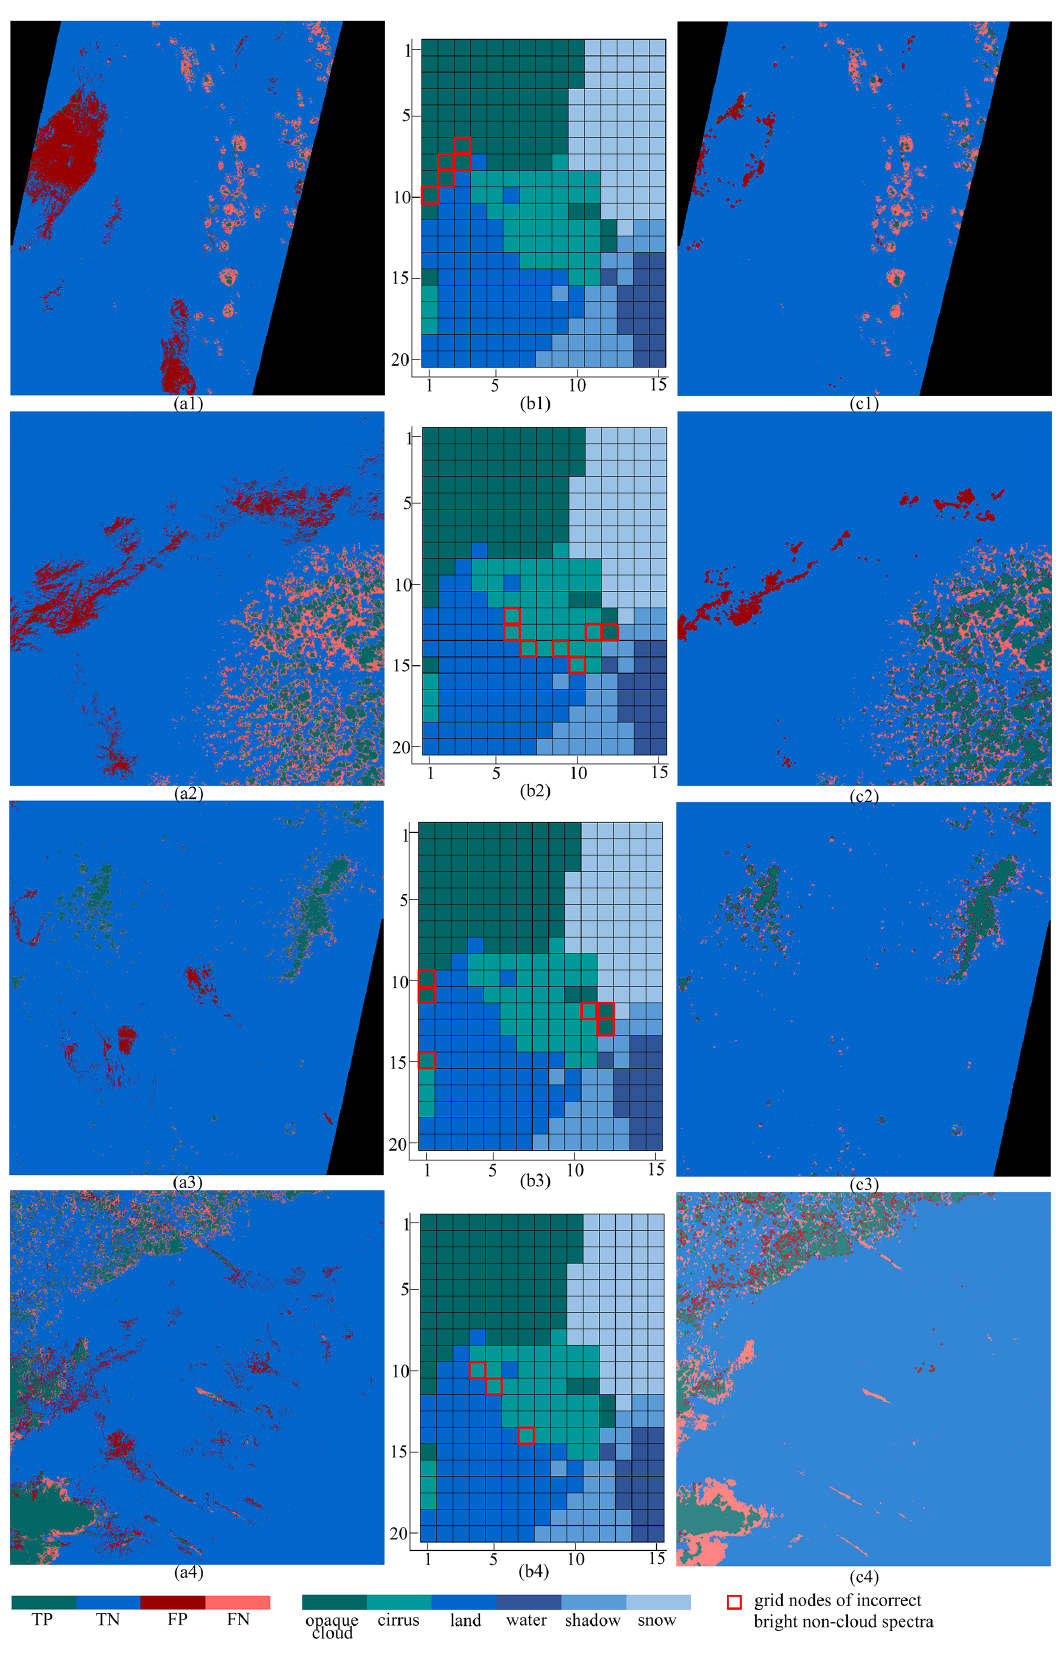
Figure 12. ( a1 – a4 ): SOM1 cloud masks, ( b1 – b4 ): neurons with altered labels, ( c1 – c4 ): SOM2 cloud